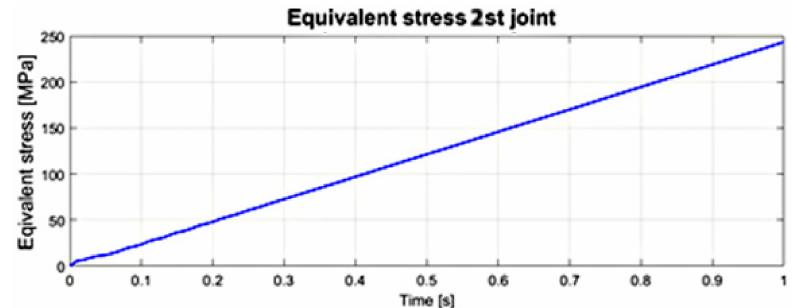
Figure 23. The course of stress reduced according to the von Mises hypothesis during the analysis of transient states—movement in the second joint of surgical robot.